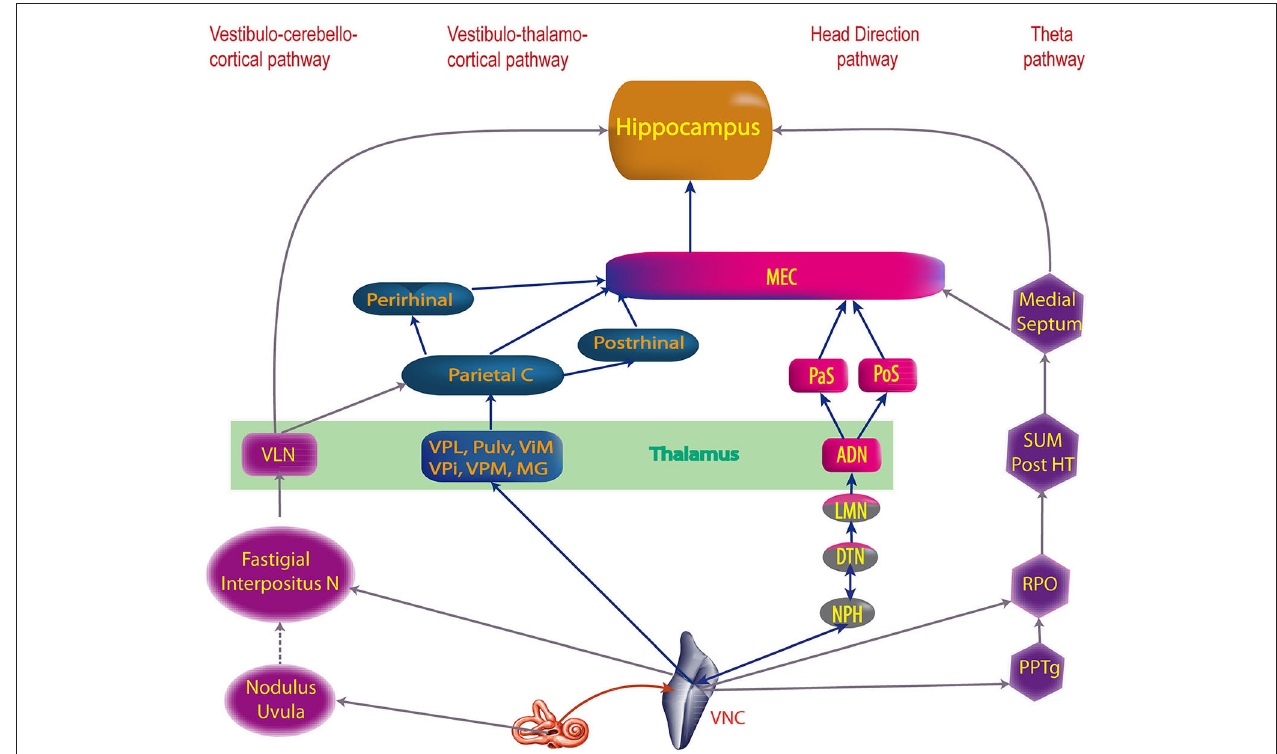
postrhinal cortex; PPTg, pedunculopontine tegmental nucleus; Pulv, pulvinar; RPO, reticularis pontis oralis; SUM, supramammillary nucleus; ViM, ventralis intermedius nuclei of the thalamus; VLN, ventral lateral nucleus of the thalamus; VNC, vestibular nucleus complex; VPi, ventral posterior inferior nucleus of the thalamus; VPL, ventral posterior lateral nucleus of the thalamus; VPM, ventral posterior medial nuclei of the thalamus (built from multiple references: cf